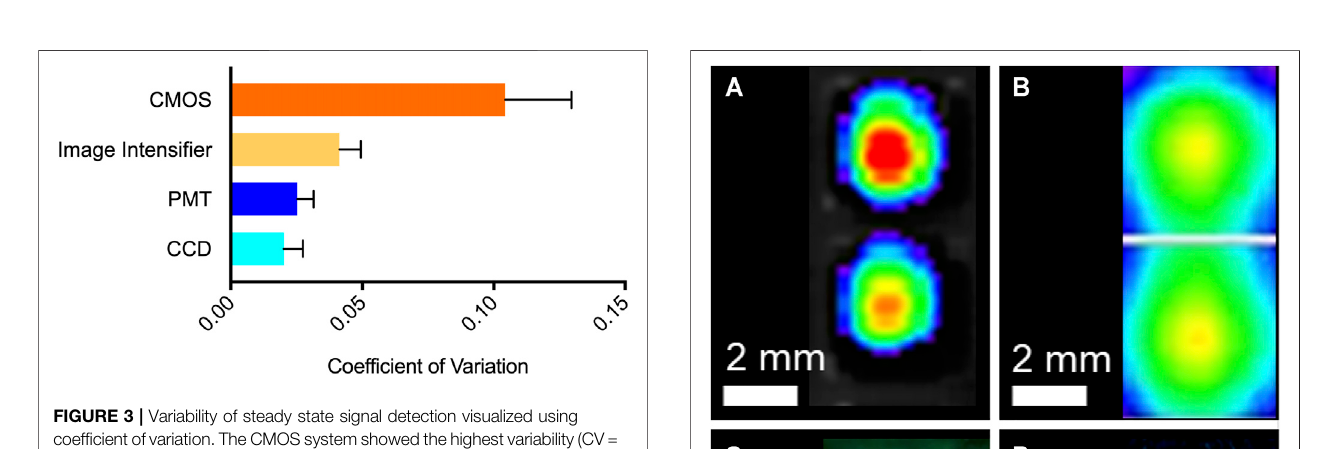
FIGURE 2 | Comparison of linear detection capabilities for different imaging systems. (A) Each system showed a high correlation between measured signal: background and cell count. The PMT system had the strongest correlation (R 2 (cid:2) 0.9942), followed by the CCD system (R 2 (cid:2) 0.9901), CMOS system (R 2 (cid:2) 0.9692), and image intensi fi er system (R 2 (cid:2) 0.9009). (B) Zoomed view of the CCD, CMOS, and image intensi fi er data points. n (cid:2) 3; error (cid:2) S.E.M.